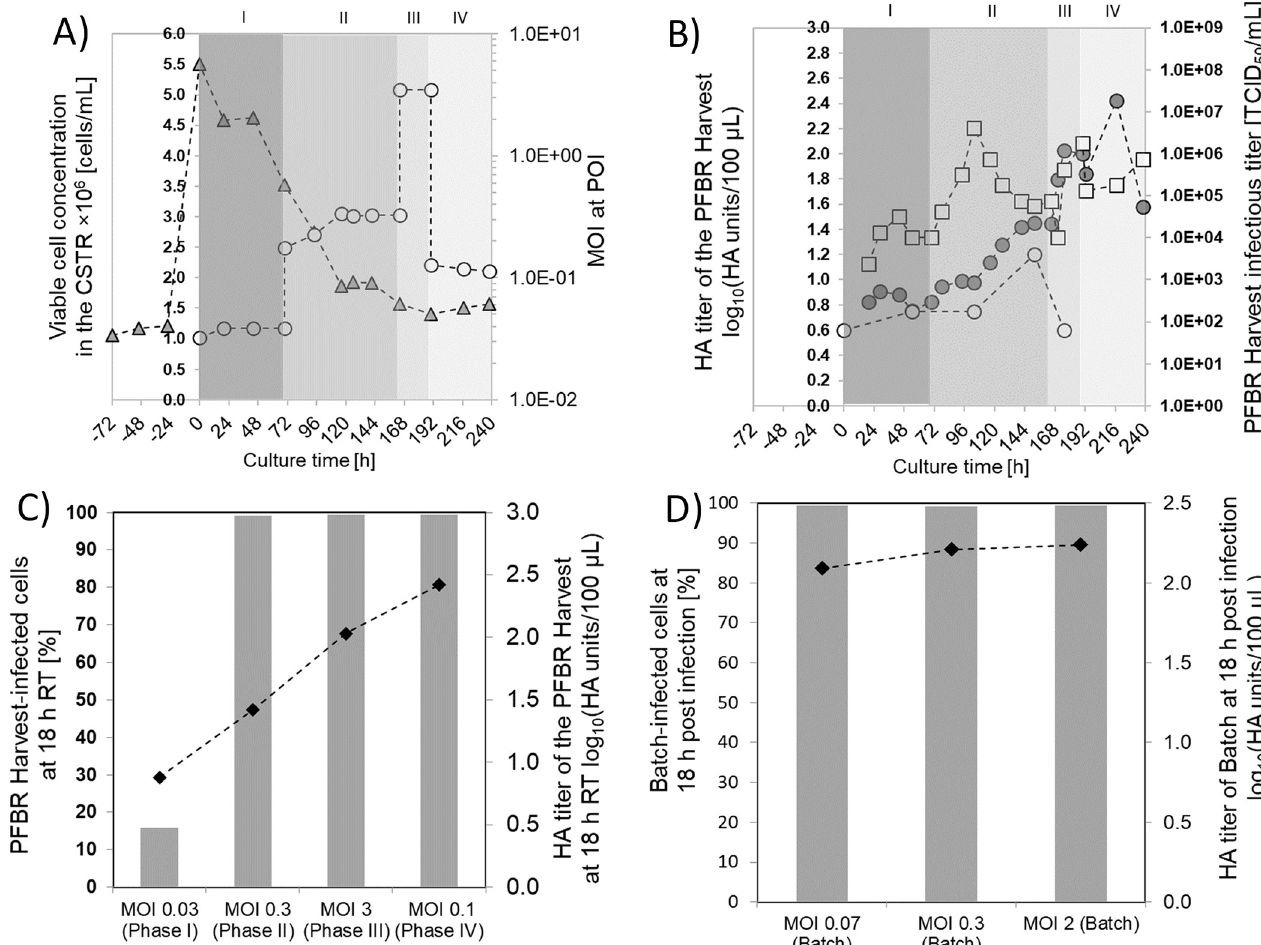
Fig 3. Impact of MOI regarding progress of infection and influenza A virus titers using MDCK.SUS2 cells in a continuous tubular bioreactor system. The PFBR had a residence time of 18 h. A) Viable cells (triangles) in the CSTR and actual MOI at the POI (circles). The different background colors show the four MOI phases. The MOI was modified by changing the concentration in the VS from 0.2 × 10 6 TCID 50 /mL (Phase I) to 0.7 × 10 6 TCID 50 /mL (Phase II), 6.2 × 10 6 TCID 50 /mL (Phase III) and back to 0.2 × 10 6 TCID 50 /mL (Phase IV). The MOI was calculated using Eq 1. B) HA titer in the PFBR Harvest (closed circles) and in the VS (open circles); TCID 50 titers in the PFBR harvest (open squares). C) Percentage of infected cells in the tubular bioreactor harvest at four different MOI (grey columns) and maximum HA titer in the PFBR harvest for each MOI condition (closed diamonds). D) Control experiment of influenza A virus propagation at 18 h post infection in batch mode (shaker flask). The percentage of infected cells (grey columns) at three different MOI, and the HA titers (closed diamonds) at 18 h post infection are shown. Suspension MDCK.SUS2 cells were used in the continuous tubular bioreactor system and for the control experiment. Negative times in Fig A and B indicate that the CSTR was already running with MDCK.SUS2 cells and with PBS in the VS.